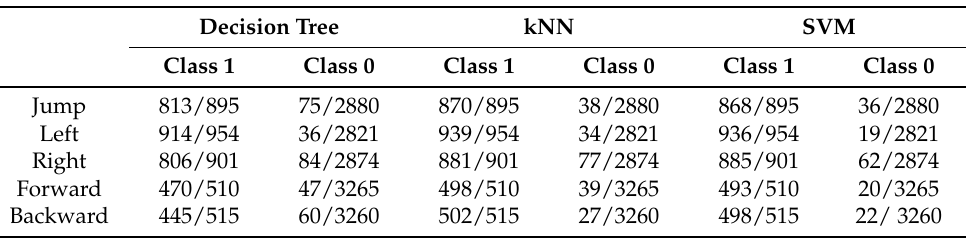
Table 2. Classification result of 10-fold cross